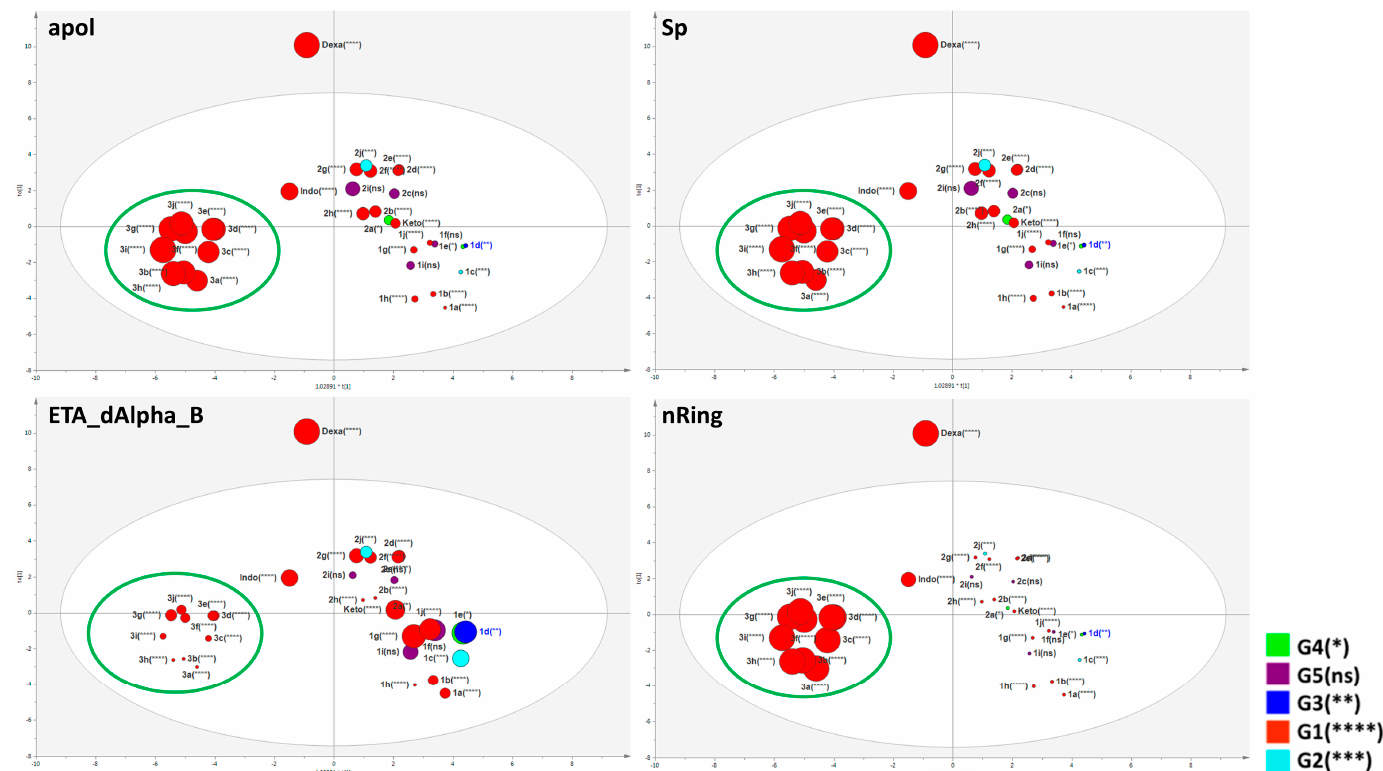
Figure 9. Score scatter plot overview for the supervised O2PLS-DA model with the twenty-eight selected PaDEL descriptors explaining the molecular features correlated to the benzophenone derivatives. The compounds used as standards in the anti-inflammatory assay (dexamethasone, indomethacin, and ketoprofen) were also evaluated. The G1 (****) grouping (highlighted in big green circles clustered to the left of the Hotelling’s t2 ellipse) represents the most similar benzophenone derivatives (in terms of structure, activity, and descriptions). Each score scatter plot demonstrates the variables correlated to a singular molecular feature, presenting different sizes to the respective values in a mode directly proportional to the respective descriptor value. Due to the structural differences between benzophenone derivatives, indomethacin, ketoprofen and dexamethasone, the compound dexamethasone is considered an outlier (as expected) since it has different chemical properties. The asterisks denote the levels of significance in comparison with vehicle ( n = 8). G1 (**** p ≤ 0.0001); G2 (*** p ≤ 0.001); G3 (** p ≤ 0.01); G4 (* p ≤ 0.05), ns = not significant.